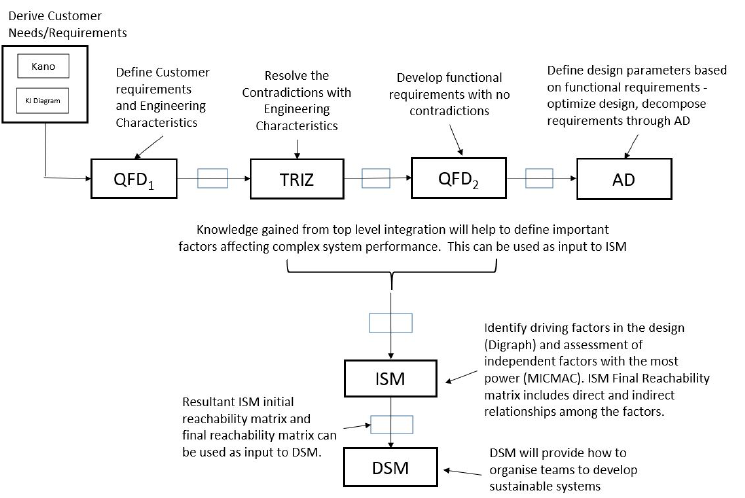
Figure 8. Unique Method of TD Tool